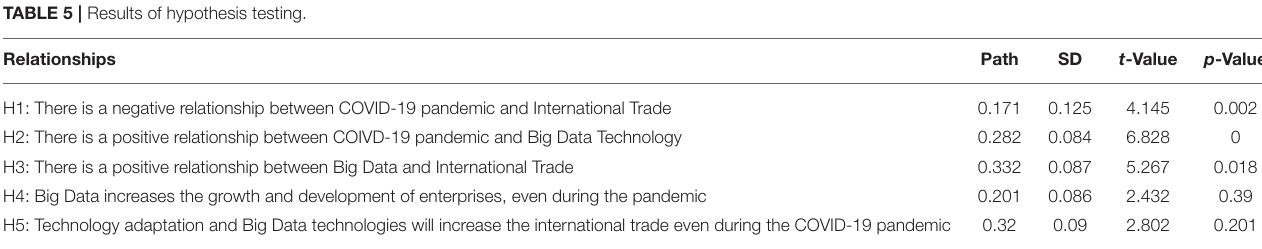
TABLE 5 | Results of hypothesis testing. Relationships